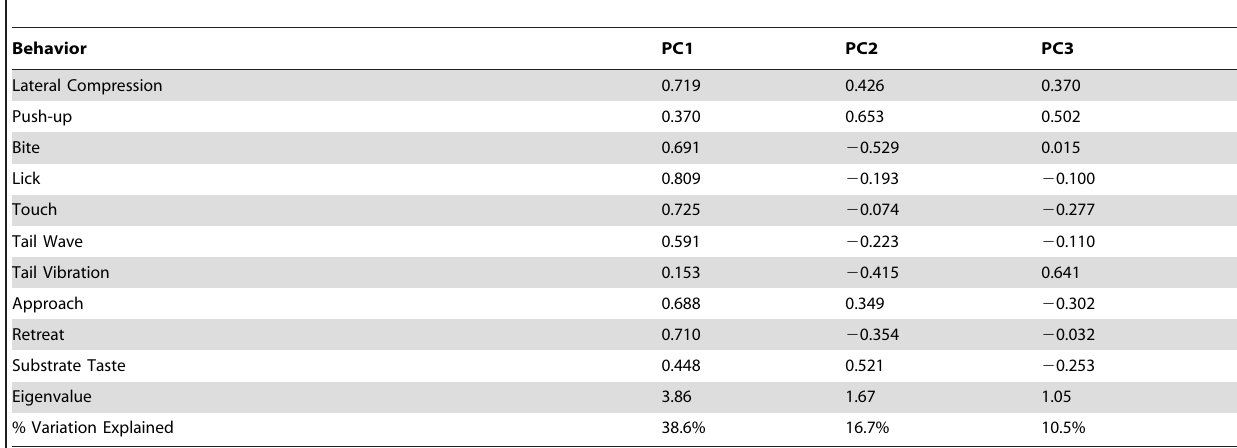
(Table 3). We calculated the discrimination index by subtracting the female’s PC2 score towards the sympatric male from her PC2 score towards the allopatric male [44]. Finally, we subtracted each female’s discrimination index in her SC trial from her discrimi- nation index in the DC trial to calculate a ‘‘discrimination differential’’ for each female (Table 3). This discrimination differential measured the degree to which a female directed more rejection behaviors toward the allopatric than the sympatric male in her DC trial relative to the degree to which she directed more rejection behaviors towards the allopatric than the sympatric male in her SC trial. A positive value of this discrimination differential would indicate that a female discriminated more between allopatric and sympatric males during her pure blue vs. pure white DC trial than during her SC trial (in which the males were more similar in coloration) (Fig. 3). If females can discriminate more easily between allopatric and sympatric males when the allopatric male is of an unfamiliar morph than when the allopatric Table 2. Loading matrix for PC axes 1–3 from a PCA on female behaviors other than copulation.